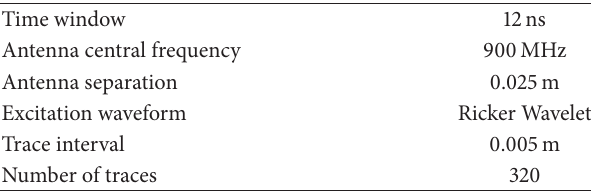
Table 1: Parameters for FDTD simulation.